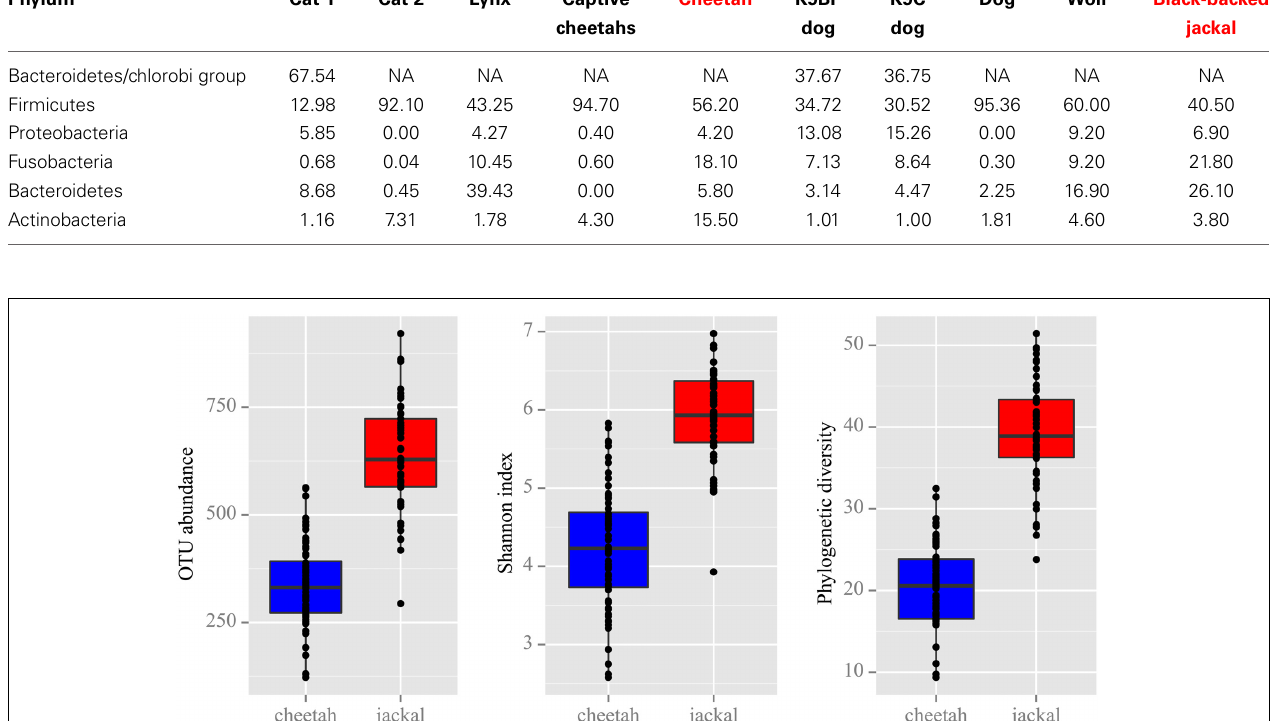
FIGURE 2 | Alpha diversity measures based on the rarefaction of 8000 reads revealed that black-backed jackals are significantly more diverse than cheetahs for OTU abundance, Shannon index and phylogenetic diversity (Wilcoxon rank sum test: all p < 0 . 001).